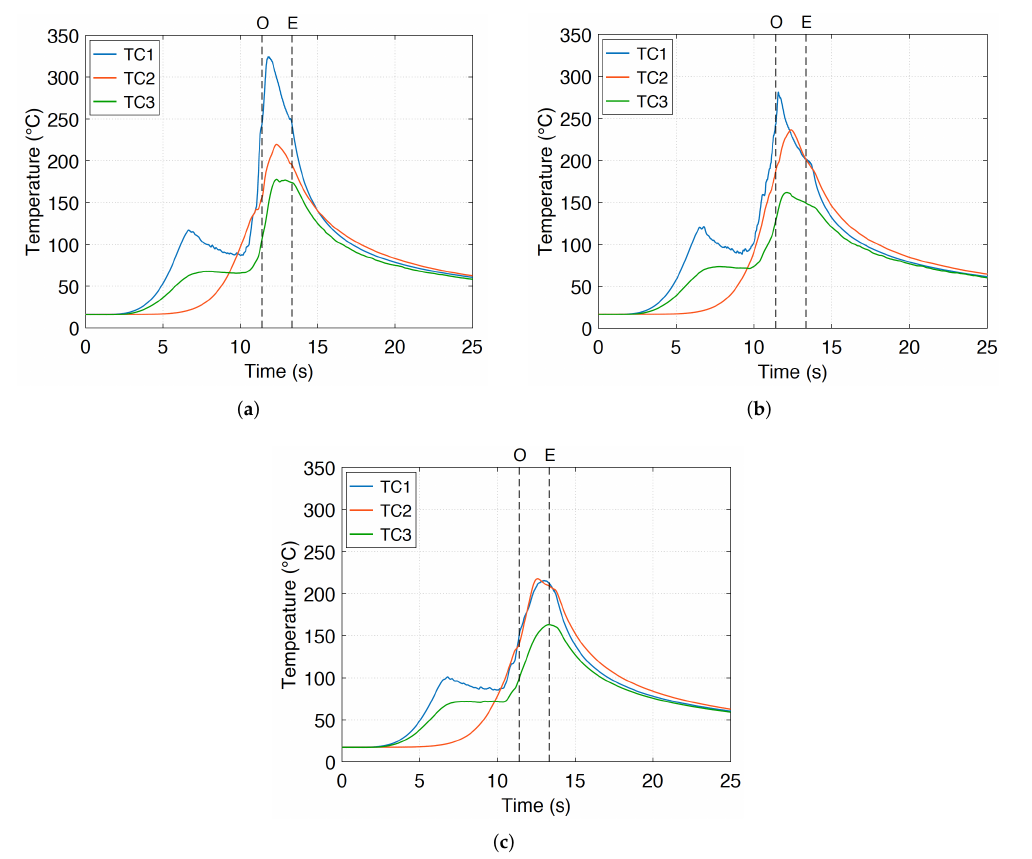
Figure 8. Temperature measurements for the 3 drilling tests: ( a ) Test n ◦ 1; ( b ) Test n ◦ 2; and ( c ) Test n ◦